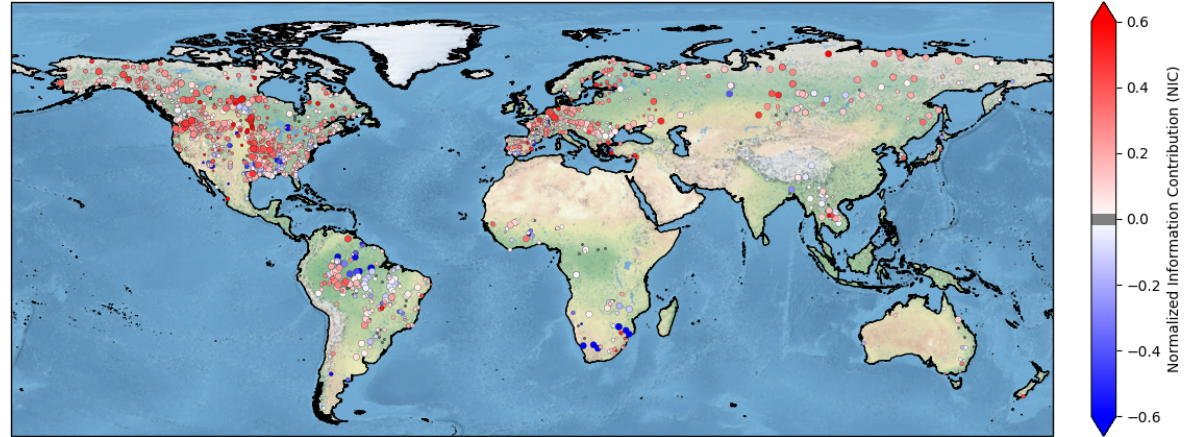
Figure 16. NIC of the Kling–Gupta efficiency between CTRIP-12D and CTRIP-HD over 2164 gauge stations (with KGE > − 1). The circle size depends on the drainage area at the